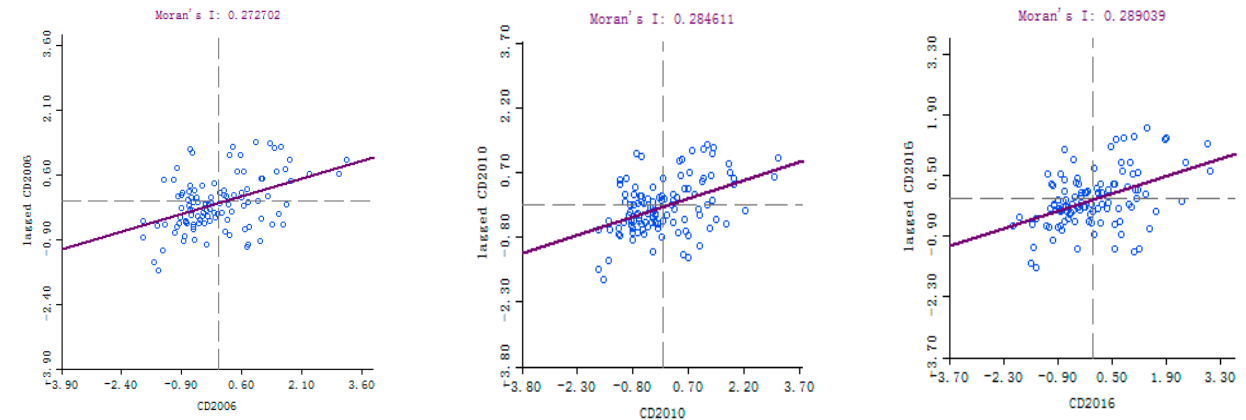
Figure 5. Moran’s I scatter plot of PLIU coordinated development in the YREB from 2006 to 2016.